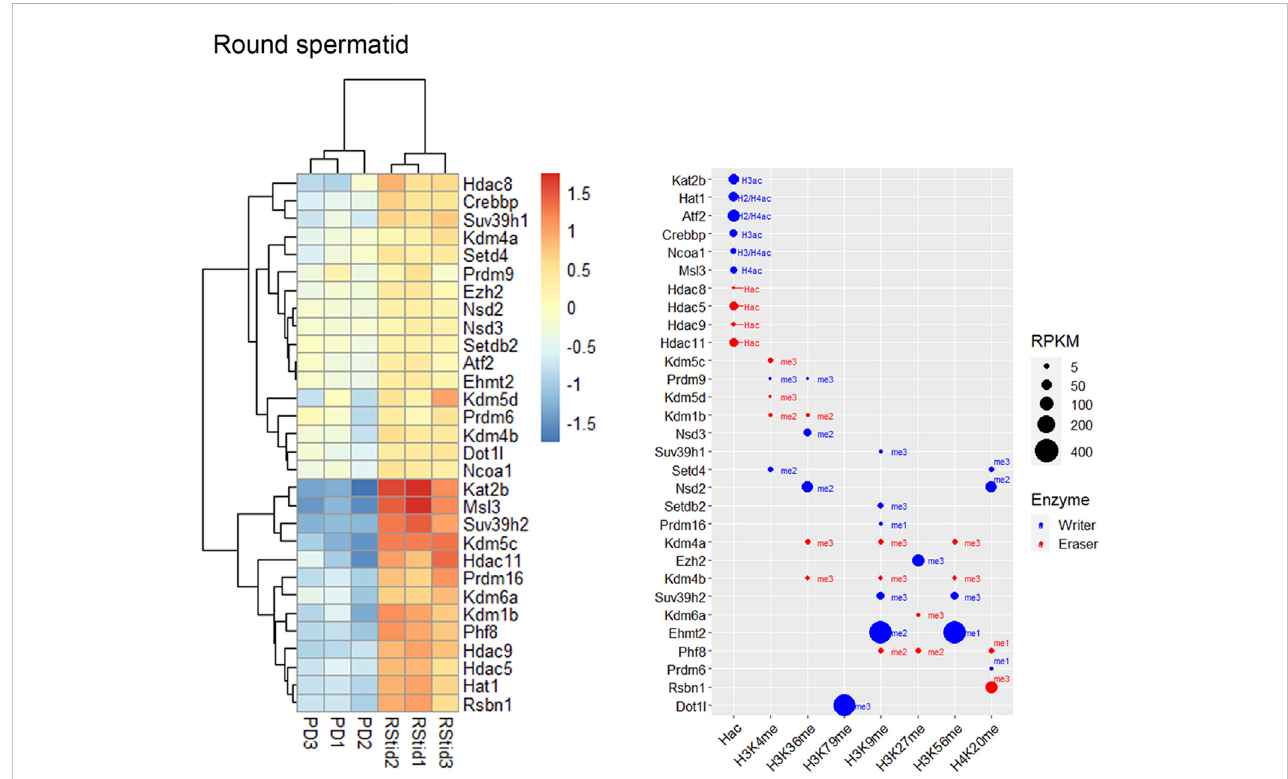
FIGURE 6 EpigenetichistoneKwritersanderasersupregulationatspermiogenesis.Theleftpanelindicatestheheatmapshowingz-scorevaluesandtherightpanel indicatesthebubble chartshowingenzymesRPKM valuesinRStid.Bluedots:writers,reddots:erasers.PD:pachytene/diplotene spermatocytes,RStid:round spermatid. The me1/2/3 reference for each dot indicates the highest methyl position reported for each lysine methylation enzyme. The H2/3/4ac reference indicatesthehistonetargetreportedforeachlysineacetylationwriter.Hacindicatesthatlysineacetylationeraserwasreportedtoeraseacetylationonall histones